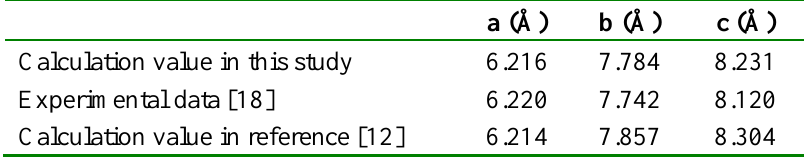
Table 1. Theoretical results and experimental data of lattice